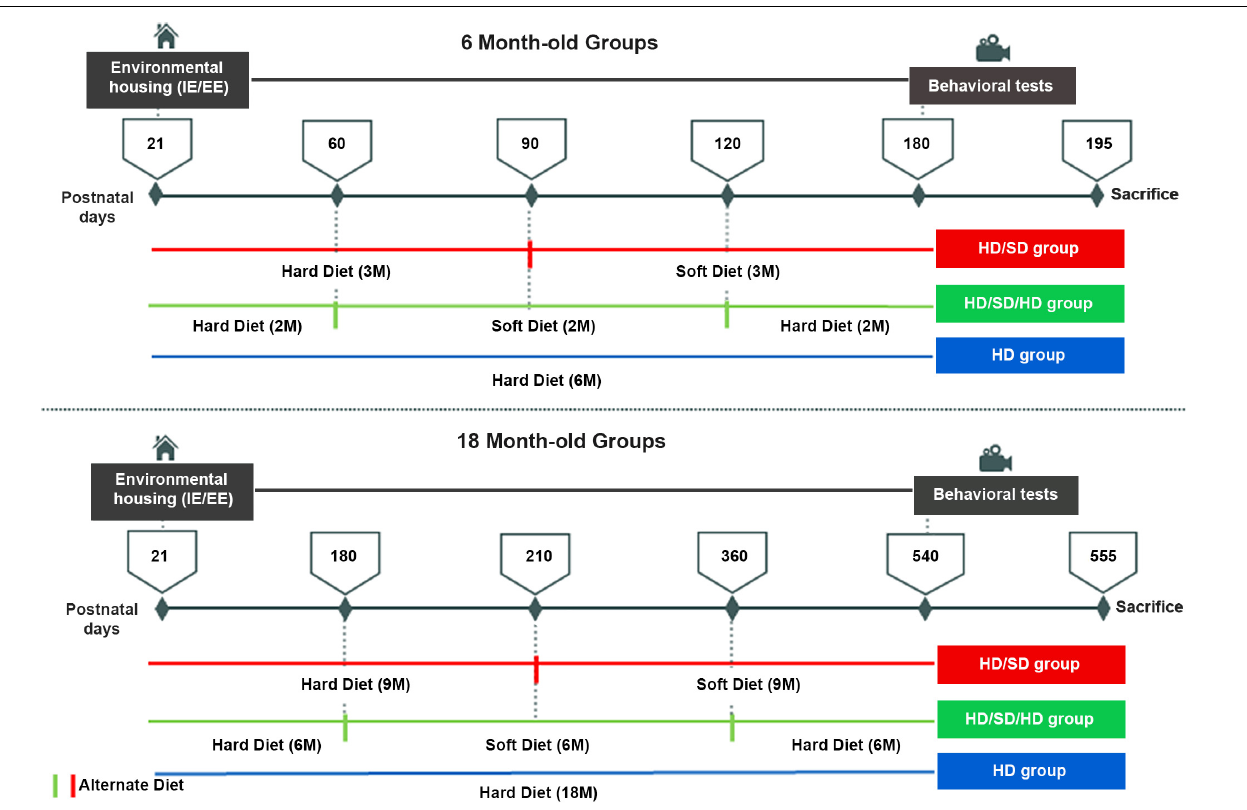
FIGURE 1 | Experimental timeline. Female albino Swiss mice were housed either in impoverished or enriched environments (IE/EE, left) from postnatal day 21 until 6M or 18M, under one of the following diet regimes: hard diet (HD) with continuous pellet diets; sequences of pellet, powder food (soft diet), and pellet food (HD/SD/HD) regimes every 2 for 6M or 6 for 18M, respectively; Alternate pellet and powder diet (HD/SD) regimes for 6 or 18M every 3 or 9M, respectively. All 6M and 18M animals were submitted to the behavioral Morris Water Maze test (right) between 180 and 195 and between 540 and 555 days of life, respectively. IE, impoverished environment; EE, enriched environment; 2M, 2-month-old; 6M, 6-month-old; 9M, 9-month-old; 18M, 18-month-old; HD, hard diet/pellet; SD, soft diet/powder food.